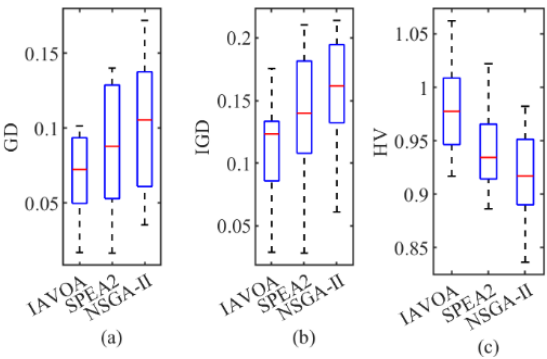
Figure 10. Box plot for the three evaluation metrics: ( a ) GD ; ( b ) IGD ; ( c ) HV .